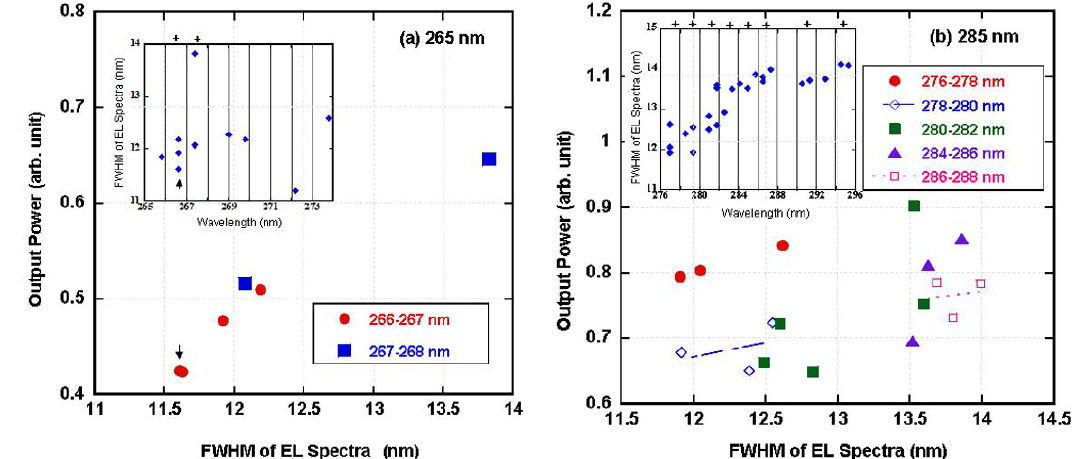
Figure 16. ( a , b ) Increased EL output in accordance with EL spectral broadening. The sapphire miscut angle was set to 1.0°. The TDD values and the density of macrosteps of the templates are considered to be within a narrow range. The numbers of ( a ) 265 nm and ( b ) 285 nm LED wafers were 11 and 23, respectively. For ( b ) 285 nm LEDs, the dependence of EL output on FWHM of EL spectra is vague to see the relationship between EL output and spectral width when the EL output and spectral width were simply mapped. When the samples wafers were grouped by the wavelength of peak EL, a positive correlation between the EL output and spectral width was seen for all groups of 285 nm LEDs, as indicated by the “+” symbols above the insets. The arrows indicate two overlapping data in graph ( a ). The dotted line in ( b ) shows the weak positive correlation. (Figures are permitted to be reused from Jpn. J. Appl. Phys. [13] © Japan Society Applied Physics).